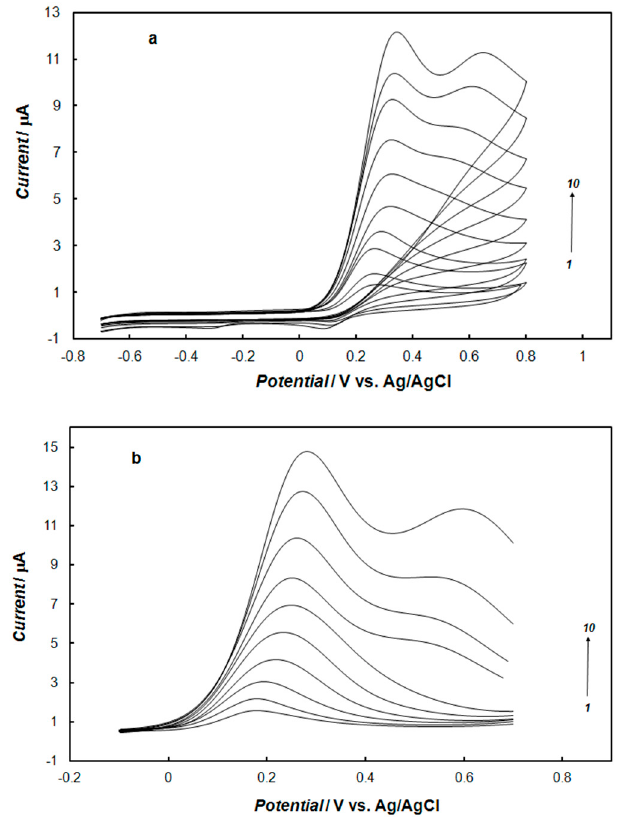
Figure 10. Cyclic ( a ) and square-wave ( b ) voltammograms recorded at the gold electrode modified with the nanocomposite of polypyrrole—MCM-48 in 0.1 M of phosphate buffer solution (pH 7.4) containing 0.1 mM of dopamine, and ascorbic acid with concentrations: ( 1 ) 0 mM, ( 2 ) 0.1 mM, ( 3 ) 0.5 mM ( 4 ) 1 mM, ( 5 ) 2 mM, ( 6 ) 3 mM, ( 7 ) 4 mM, ( 8 ) 5 mM, ( 9 ) 6 mM, and ( 10 ) 7 mM. The potential sweep rate was 0.1 V s − 1 . The square wave amplitude was 25 mV, frequency was 25 Hz, and step potential was 4 mV.